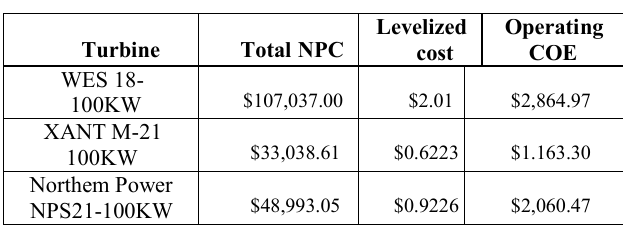
Table 10. Result by